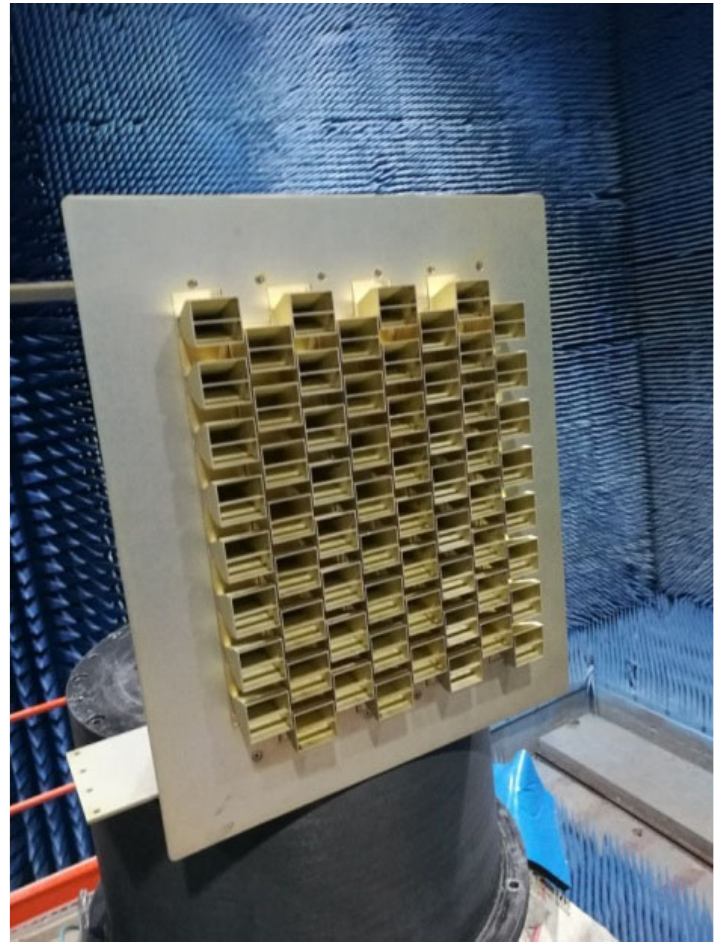
Figure 12. Photograph of the assembled antenna.